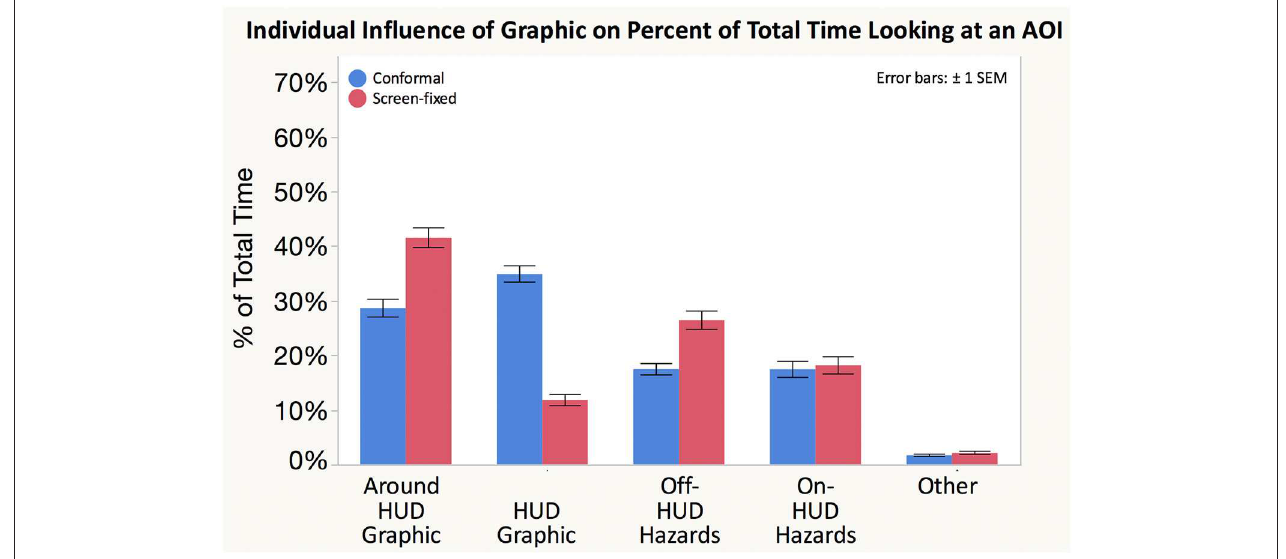
FIGURE 8 | The percentage of fixations allocated to each AOI differed between Conformal and Screen-fixed displays. While there is no ideal allocation across AOIs, it is interesting to note that the percentages vary, particularly between percentage of time spent looking at and around the HUD